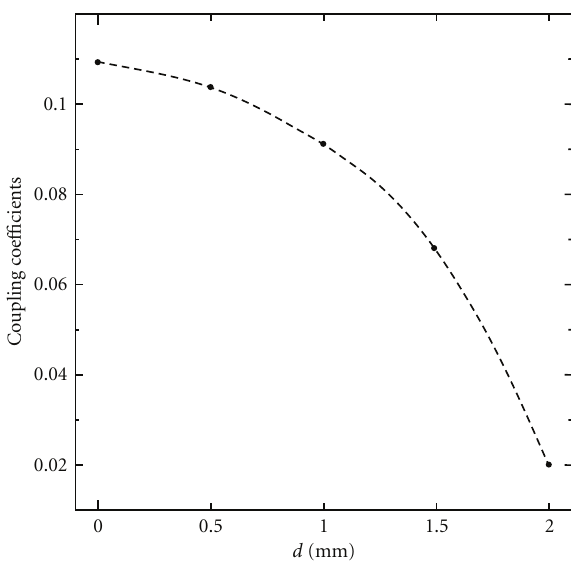
Figure 8: Coupling coe ffi cients as a function of d ( a = 5 . 2 mm).